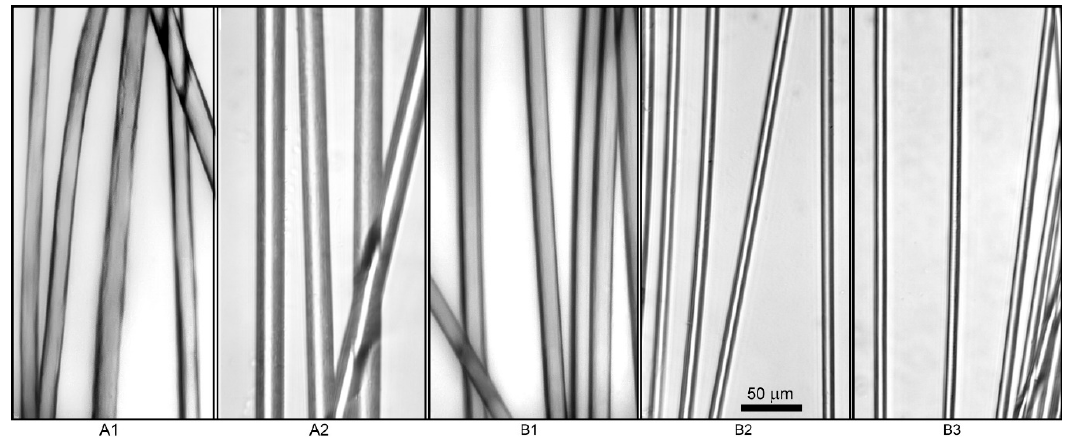
Figure 13. Microphotographs of fibers obtained from PAN solutions. ( A1 ) RAFT, continuous; ( A2 ) RAFT, semi-batch; ( B1 ) FRP, continuous; ( B2 ) FRP, semi-batch; ( B3 ) FRP, batch. Scale bar is equal for all samples.